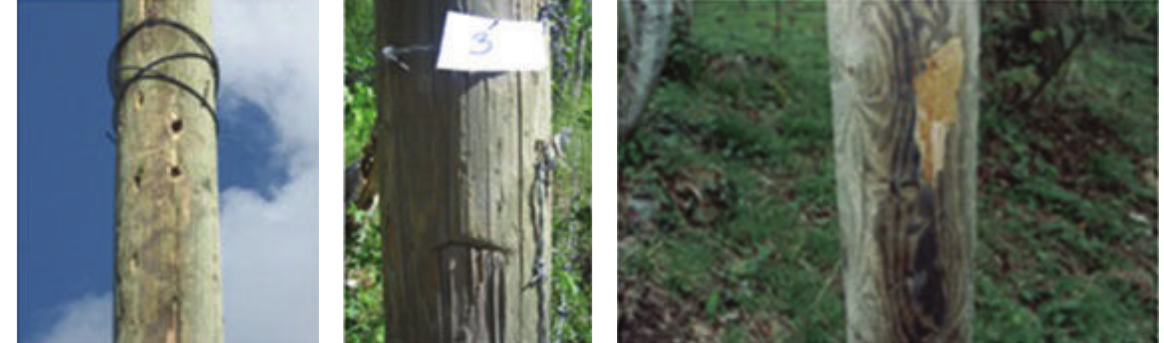
Figure 7: Damages on the utility poles were caused by people and wood peckers.